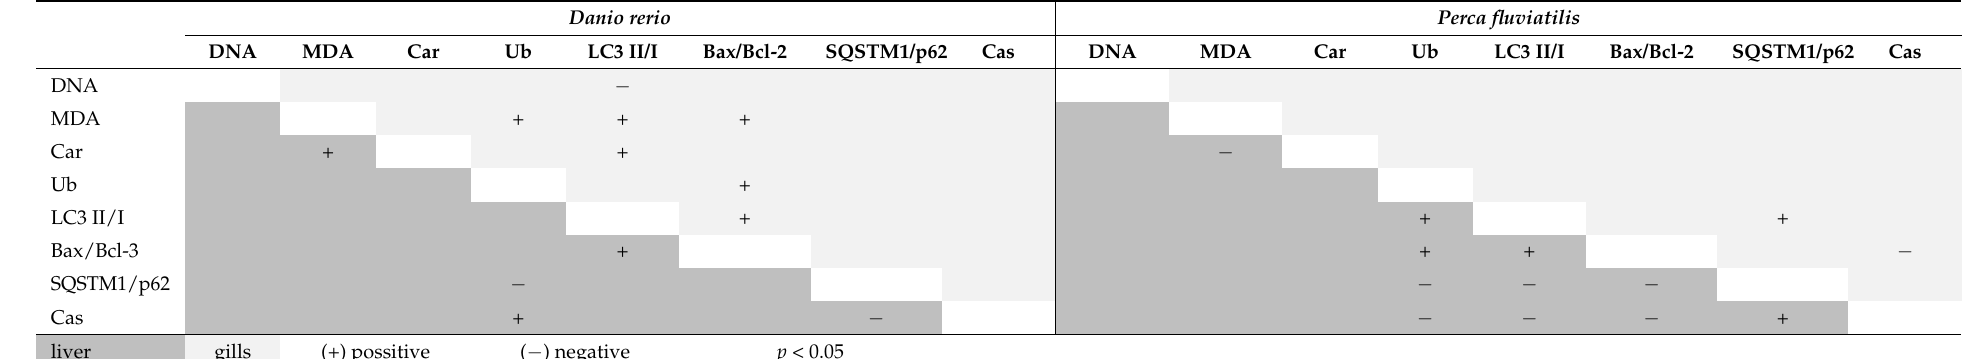
Table 2. Spearman’s rank correlation matrix between molecular and biochemical biomarkers measured in the gills and liver of Danio rerio and Perca fluviatilis